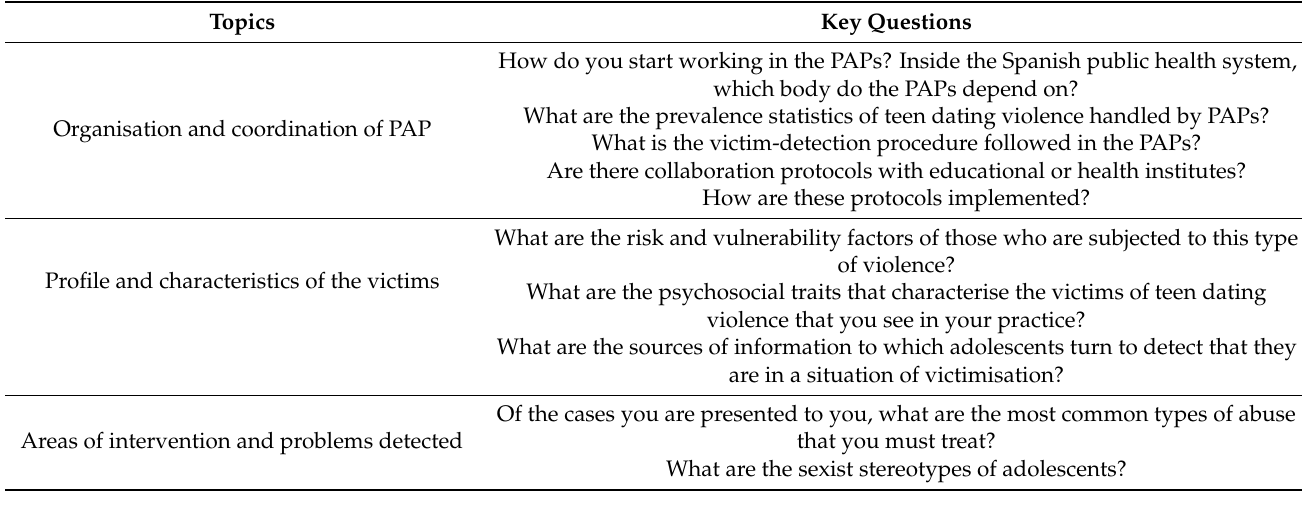
Table 2. Themes and key questions included in the interview